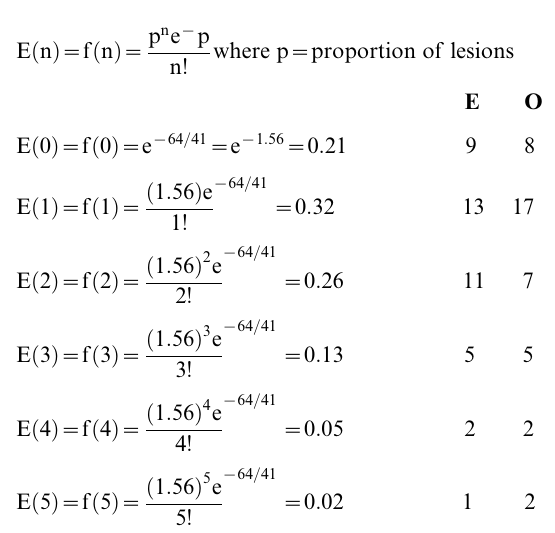
Table S2 Gene content differences between mouse and human.